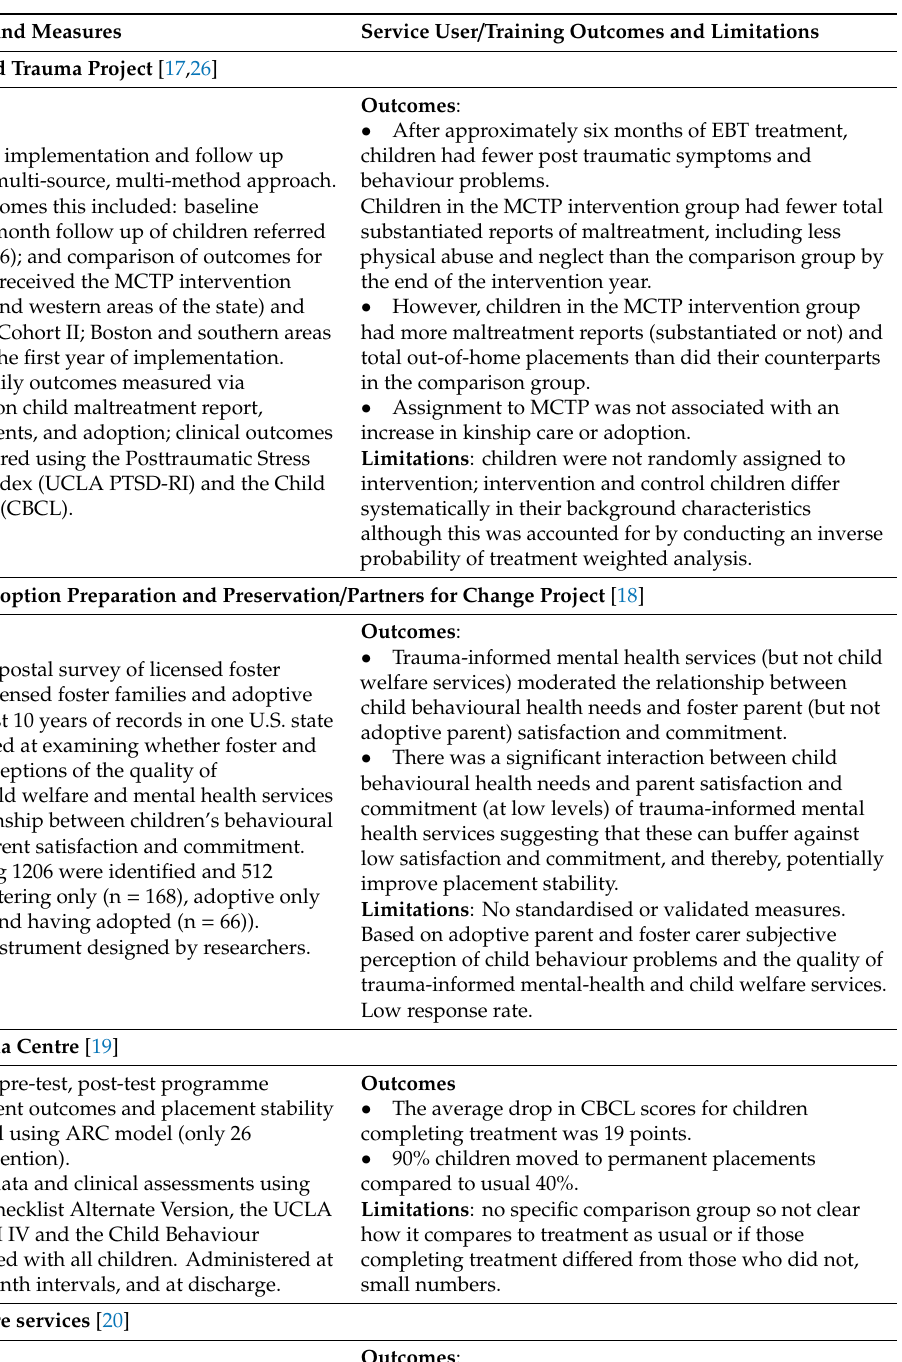
Table 3. Empirical service user / treatment outcomes ( n =